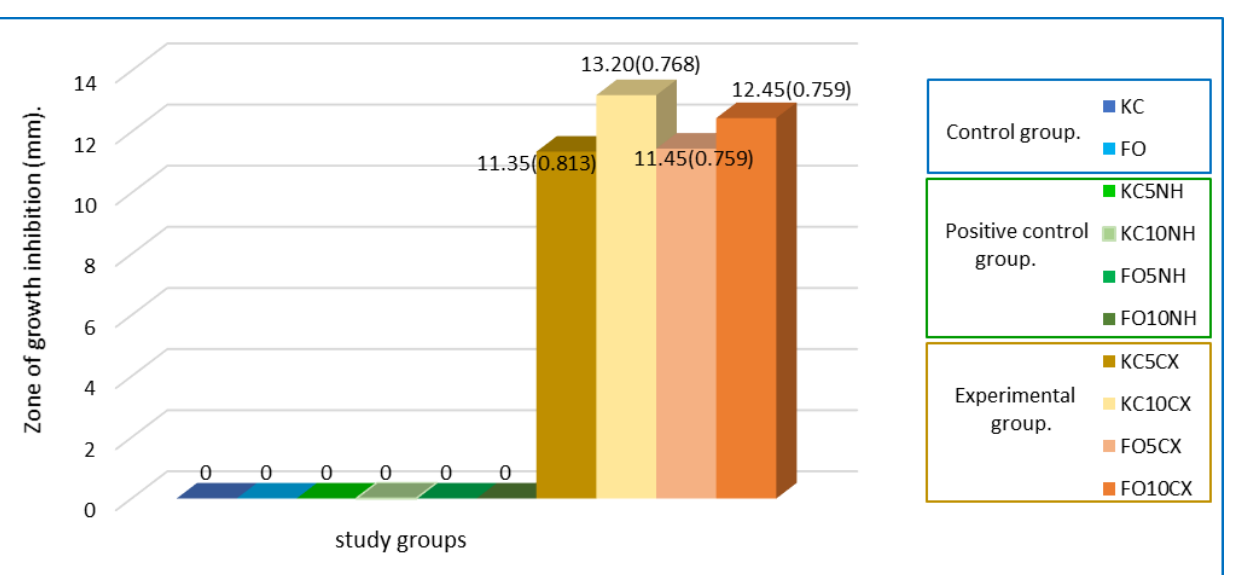
Table 1. Comparison of inhibitory effect from experimental groups analyzed in this study. Groups